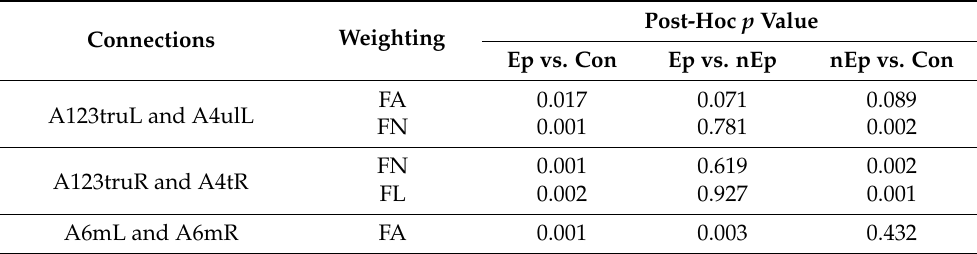
Table 2. Connections with significant inter-group differences.